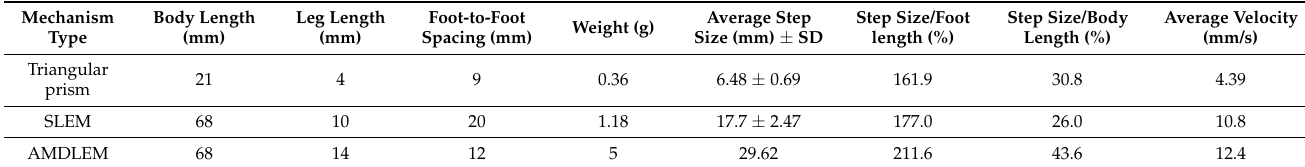
Table 3. Types of mechanisms and their attributes and locomotion results showing locomotion effi- ciency.